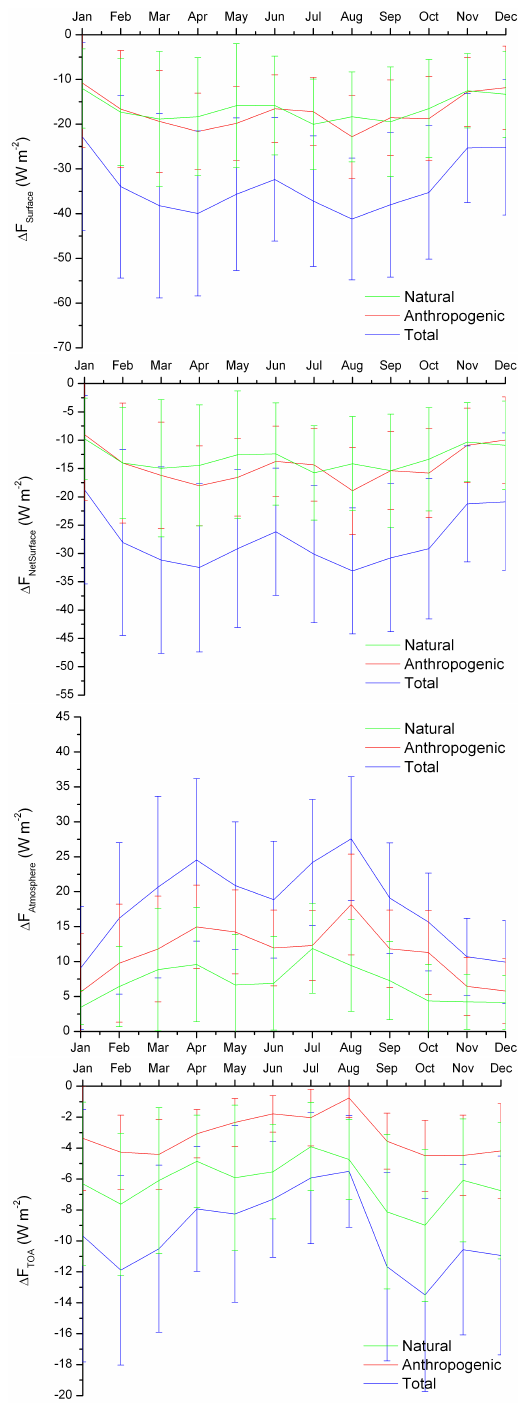
Fig. 13. Mean monthly aerosol DRE and its components (anthro- pogenic and natural) with standard deviations for the period 2002– 2010 (a) incident at the surface (HCMR Station), (b) absorbed by the surface, (c) in the atmosphere and (d) at TOA, derived using Aqua MODIS